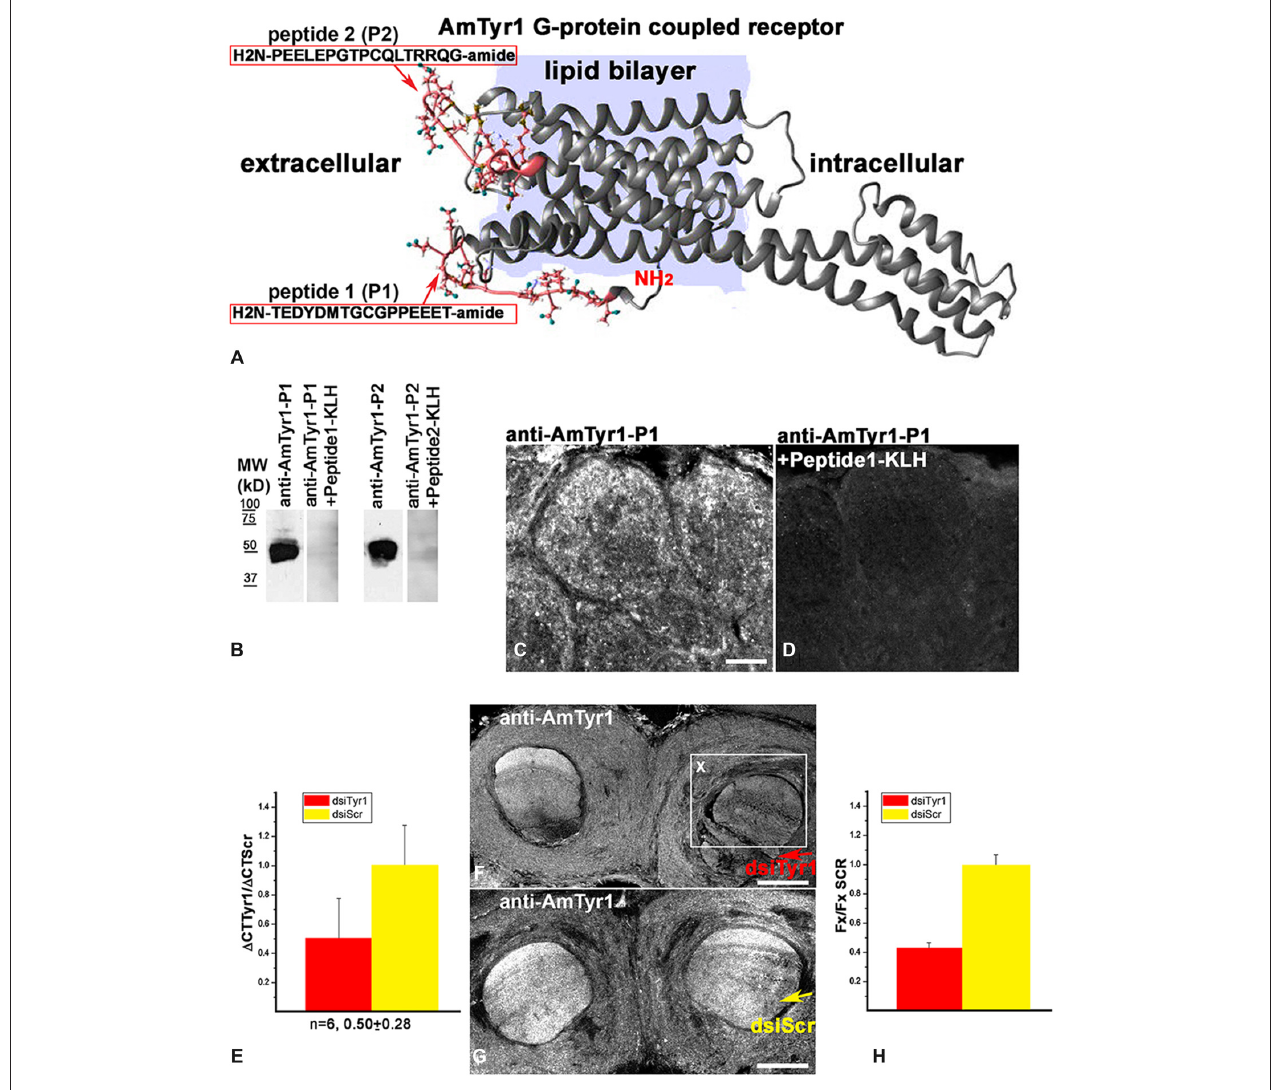
FIGURE 2 | Characterization of anti-AmTyr1 antibodies. (A) Predicted structural model of the Apis mellifera tyramine receptor (NP_001011594.1). Peptides (P1, P2) from the N-terminal region and the loop between helices 4 and 5 used to generate the antibodies are represented by their amino acid sequence (pink). (B) Affinity purified anti-AmTyr1 antibodies against peptide-1 and peptide-2 were tested in western analyses. The relative positions of molecular weight (MW) standards in kDa are indicated. The affinity purified anti-AmTyr1-P1 and anti-AmTyr1-P2 each revealed a band corresponding to an approximate molecular weight of 45 KDa. Preincubation of the anti-AmTyr1 antibodies separately with corresponding peptide conjugates abolished the band. (C) Anti-AmTyr1 immunostainings in the antennal lobe revealed processes in the cortex of glomeruli on frontal section of the brain. (D) In the next consecutive section, staining in glomeruli was not present when the anti-AmTYR1 antibodies were pre-incubated with Keyhole Limpet Hemocyanin (KLH)-conjugated peptide-1 before immunostaining. (E) Expression of AmTyr1 gene in brains injected with 70 nl of 100 µ M dsiAmTyr1 RNA or dsiScramble 14 h after treatments. AmActin was used as a reference gene. The relative gene expression was calculated using the 2 − ∆∆ Ct method. The data are expressed as mean ± SE. (F) Anti-AmTyr1 staining in the brain section 18 h after injection dsiAmTyr1 RNA (G) and dsiScr. Arrows in (F,G) indicate injections sites in the frontal sections of the bee brains. (H) Quantification of the average fluorescence intensity value in the box X (Fx), outlined in F in the raw images of brains that were injected with dsiTyr1 and dsiScr. Images were collected with a confocal fluorescent microscope with the same gain settings and intensity level. Relative intensity level of fluorescence dropped to 42 ± 5% (mean ± SE) in the dsiTyr1 injected brains compared to dsiScr brains in the local area of the injections. Scale bar: C,D = 10 µ m, F,G = 100 µ m.